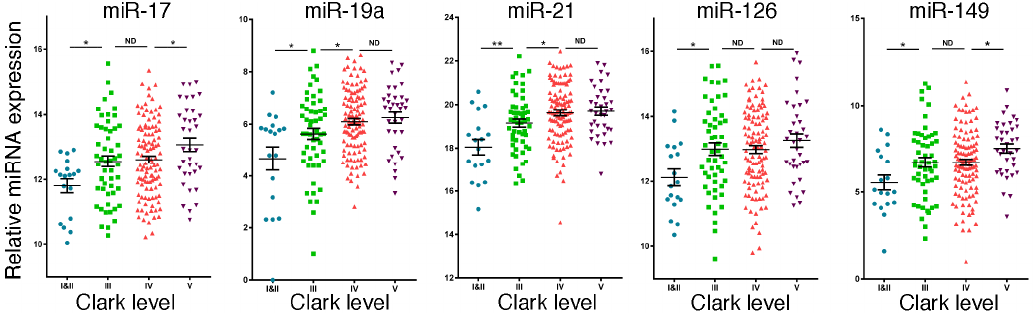
Figure 3. MiRNA expression in plasma ‐ derived exosomes from individuals with metastatic melanoma and normal volunteers. RNA was prepared from plasma ‐ derived exosomes from individuals with metastatic melanoma and normal volunteers. MiRNA expression was determined by qPCR ( n = 3) and normalized to the spiked ‐ in levels of Cel39.